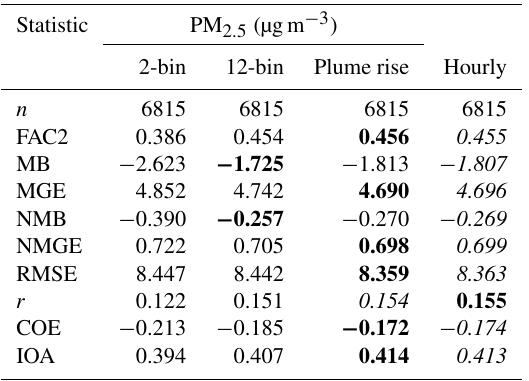
Table 3. Statistical comparison of GEM-MACH model simulation of surface PM 2 . 5 with measurements from the WBEA observations between 10 August and 10 September, 2013. Boldface type indi- cates best score; italics indicates second best score.